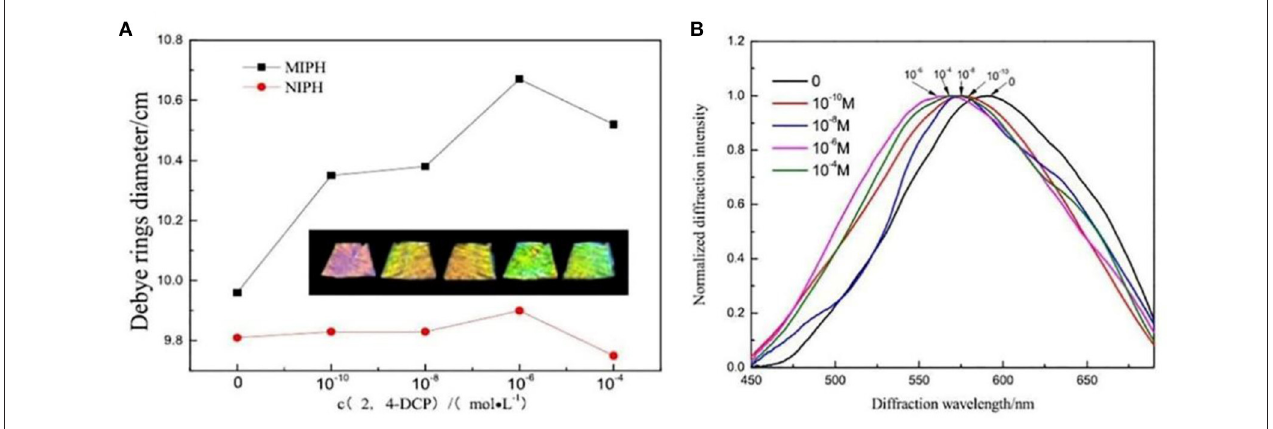
FIGURE 6 | Dependence of (A) particle spacing of MIPH/ non-molecularly imprinted two-dimensional photonic crystals hydrogels (NIPH) in 2,4-DCP solution; (B) normalized diffraction spectra of MIPH in different concentrations of 2,4-DCP solution (reprinted with the permission of Qin et al., 2020; copyright 2020